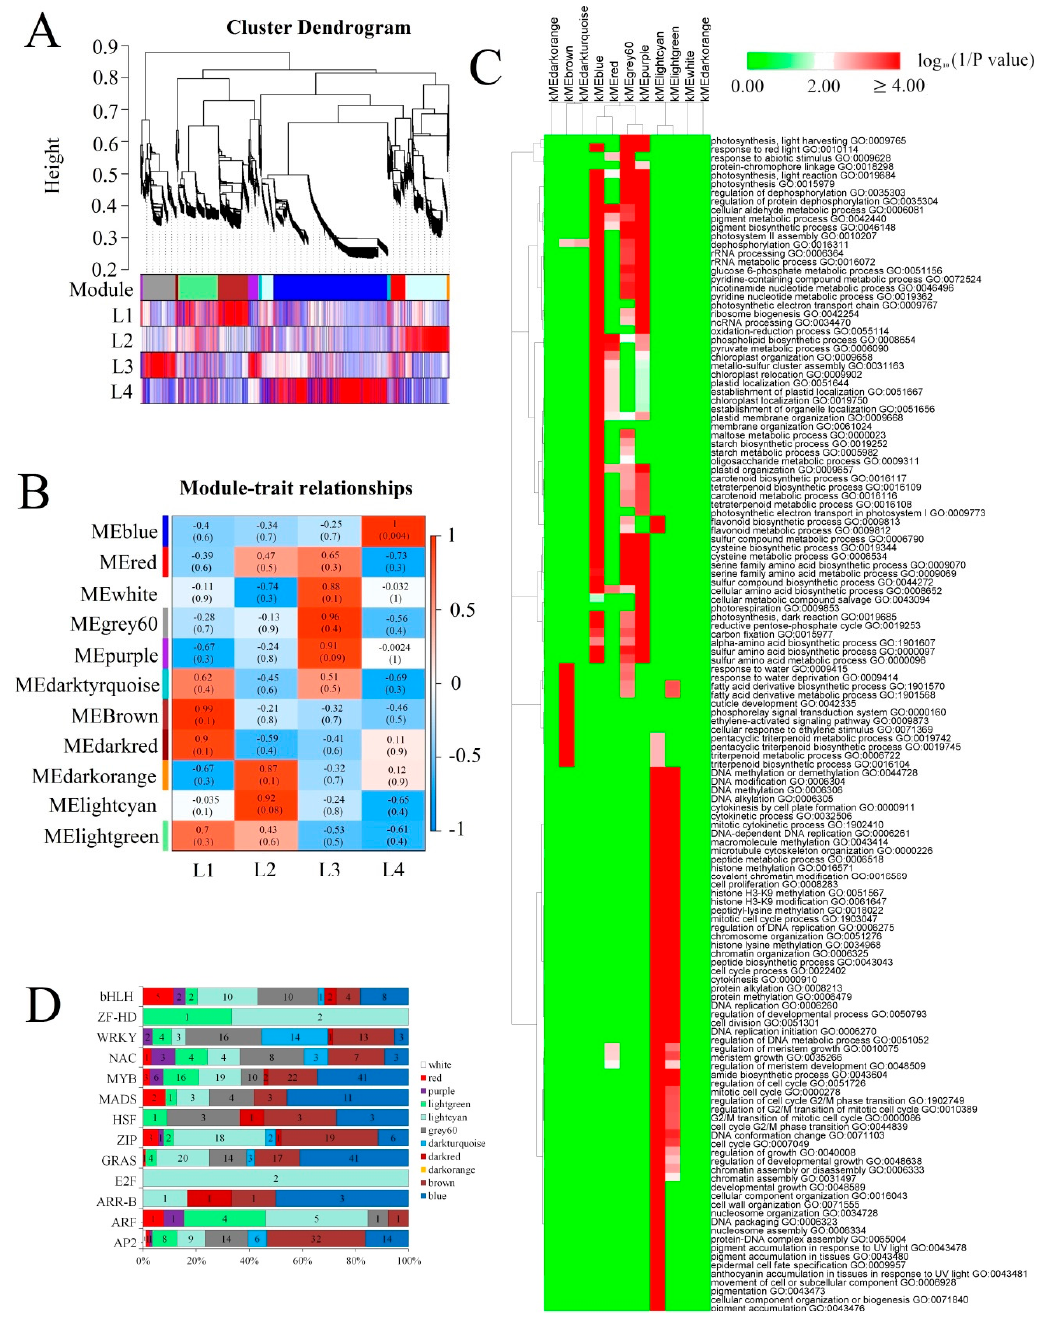
Figure 3. Weighted correlation network analysis (WGCNA) of all expressed Eucommia ulmoides isoforms. ( A ) Cluster dendrogram of expressed isoforms based on expression levels in the four growth stages. Each branch in the tree represents one isoform, and di ff erent colours represent di ff erent isoform co-expression modules. ( B ) Module–group association. The expression patterns of eleven major modules are shown by the heat map. Each row represents an expression module, while each column corresponds to a sample group. The colour of each cell at the row-column intersection indicates the correlation coe ffi cient between the module and group. The colour bar indicates the degree of correlation from low (blue) to high (red). ( C ) Gene ontology (GO) enrichment analysis of isoforms in each cluster. The − log 10 p values and adjusted p values ≤ 0.0005 are included to indicate significant enrichment. Green indicates high p values, and red indicates low p values. ( D ) Distribution of transcription factors in di ff erent